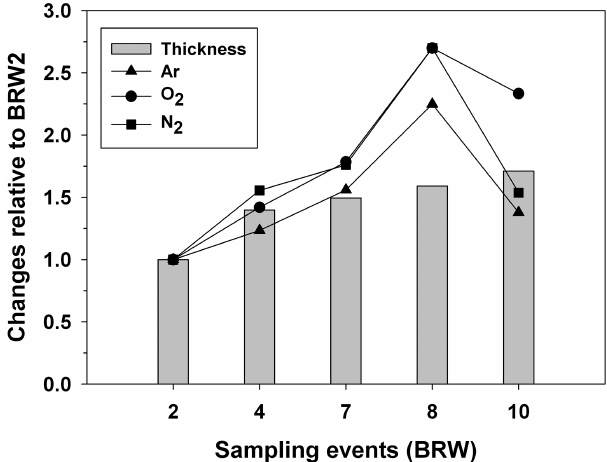
Figure 6. Changes of ice thickness, Ar, O 2 and N 2 concentrations for each sampling event relative to BRW2. Value above, equal to or below 1 indicates an observed change that is respectively higher, equal to or lower than the value in